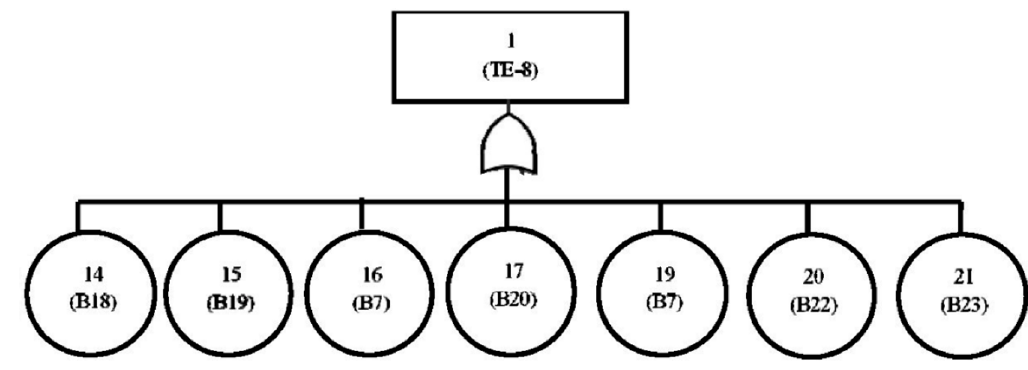
Figure 9. Simplification of FT-8.